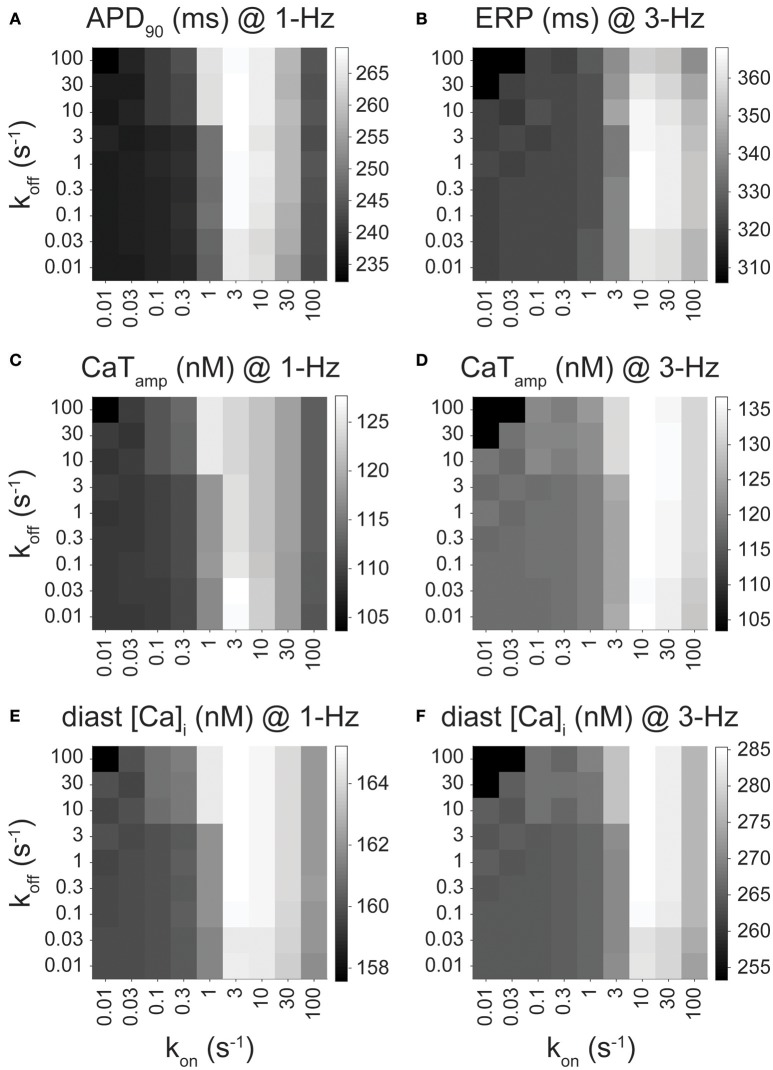
Effect of drug-binding kinetics on APD90, ERP, CaTamp, and diastolic [Ca2+]i for an open and inactivated state blocker. (A) APD90 (at 1 Hz), (B) ERP (at 3 Hz), (C,D) CaTamp (at 1 and 3 Hz), and (E,F) diastolic [Ca2+]i (at 1 and 3 Hz) are plotted for open and inactivated state blockers with varying binding kinetics, which were simulated via permutations of nine different drug-binding rates of (from 0.01 to 100 s−1) while keeping kon,O = kon,I and koff,O = koff,I. CaTamp is 103.6, 109.4, and 120.4 nM at 1 Hz, and 103.4, 120.4, and 135.9 nM at 3 Hz for drug-free, 50 and 100% IKur block, respectively. Diastolic [Ca2+]i is 157.6, 160.0, and 165.2 nM at 1 Hz, and 253.3, 266.9, and 286.9 nM at 3 Hz for drug-free, 50 and 100% IKur block, respectively.